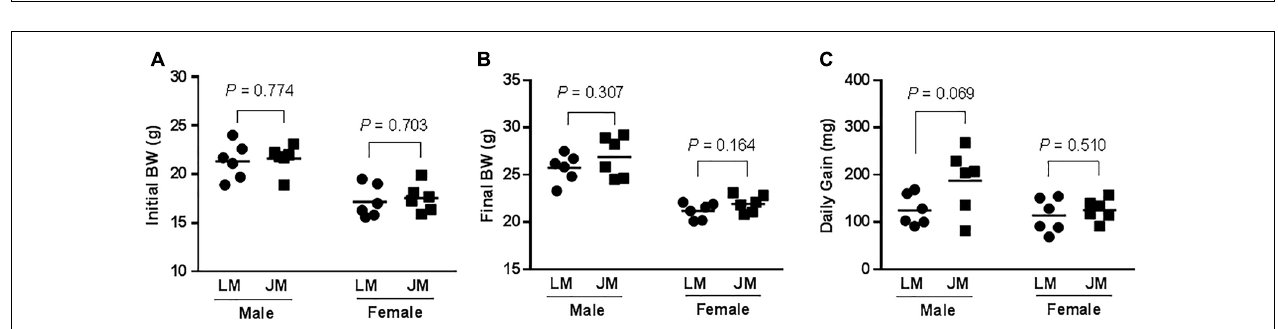
FIGURE 6 | Principal coordinates analysis (PCoA) of the cecal bacterial community composition of mouse recipients based on weighted unifrac distance. JD, Jinhua pig donor; LD, Landrace pig donor; JM, mice receiving fecal microbiota from Jinhua pigs; LM, mice receiving fecal microbiota from Landrace pigs.